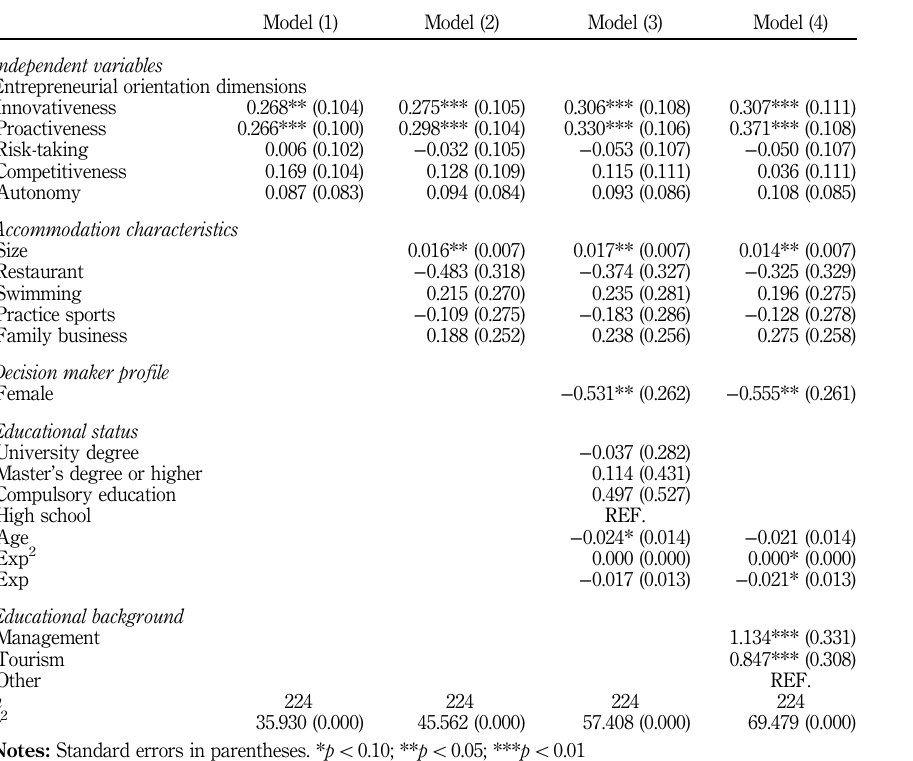
Table VIII. Ordered